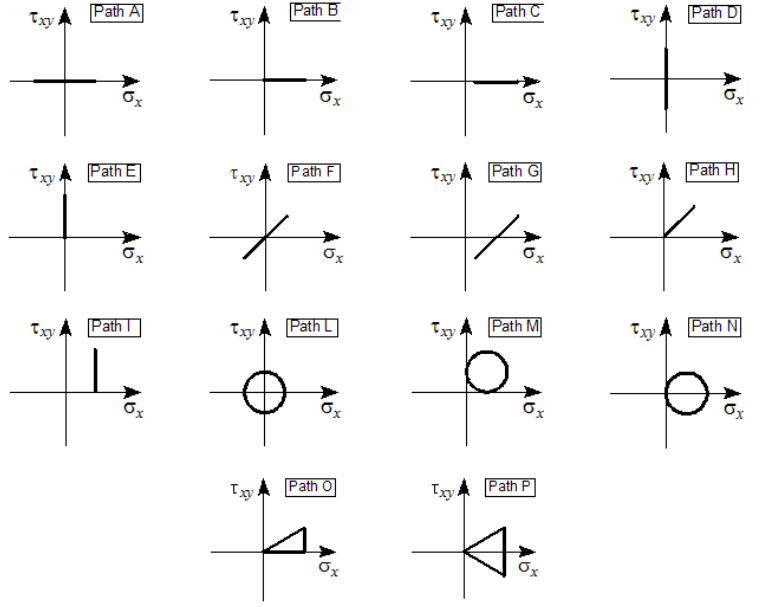
Figure 3: Summary of nominal loading